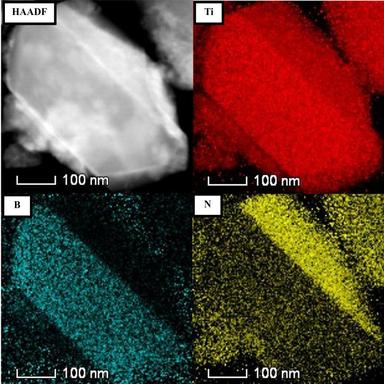
High-angle annular dark field image (HAADF) and Energy-Dispersive X-ray Spectroscopy (EDS) mapping for 600TiBCN.